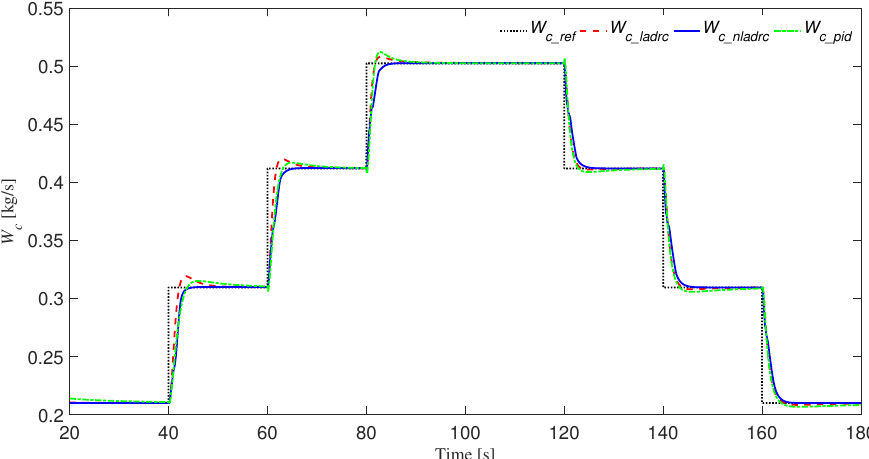
Figure 14. The response curve of mass air flow under different fuel injection